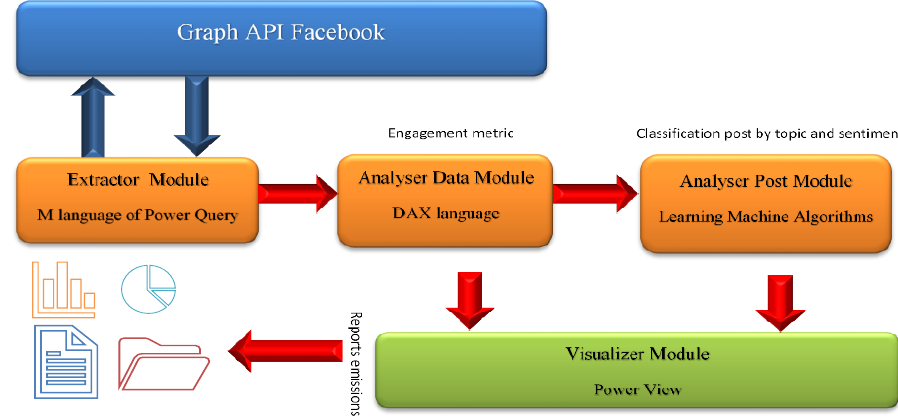
Figure 1. Software Figure 1. Software Architecture.